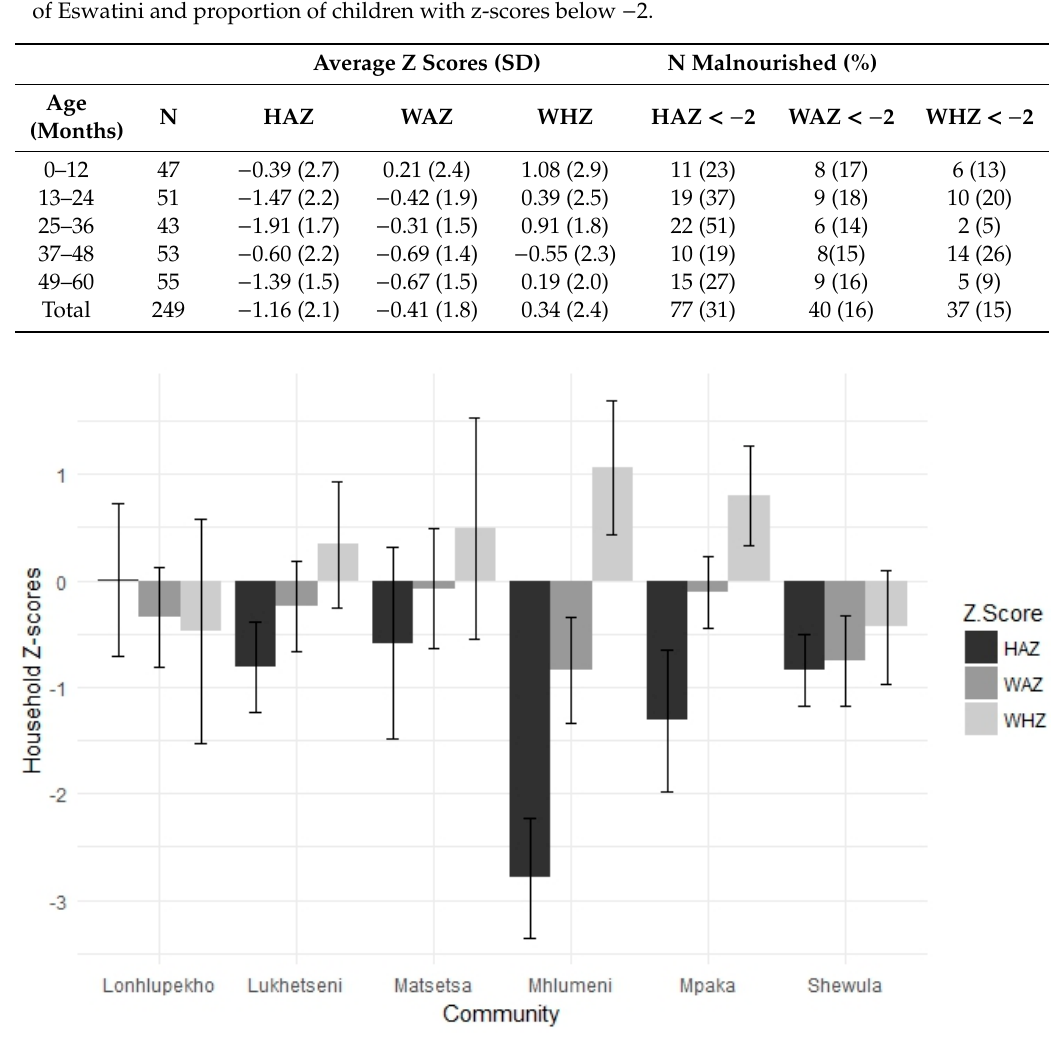
Figure 2. Average z-scores for children under the age of five in households across the six survey communities in the Lowveld and Lubombo regions of Eswatini.